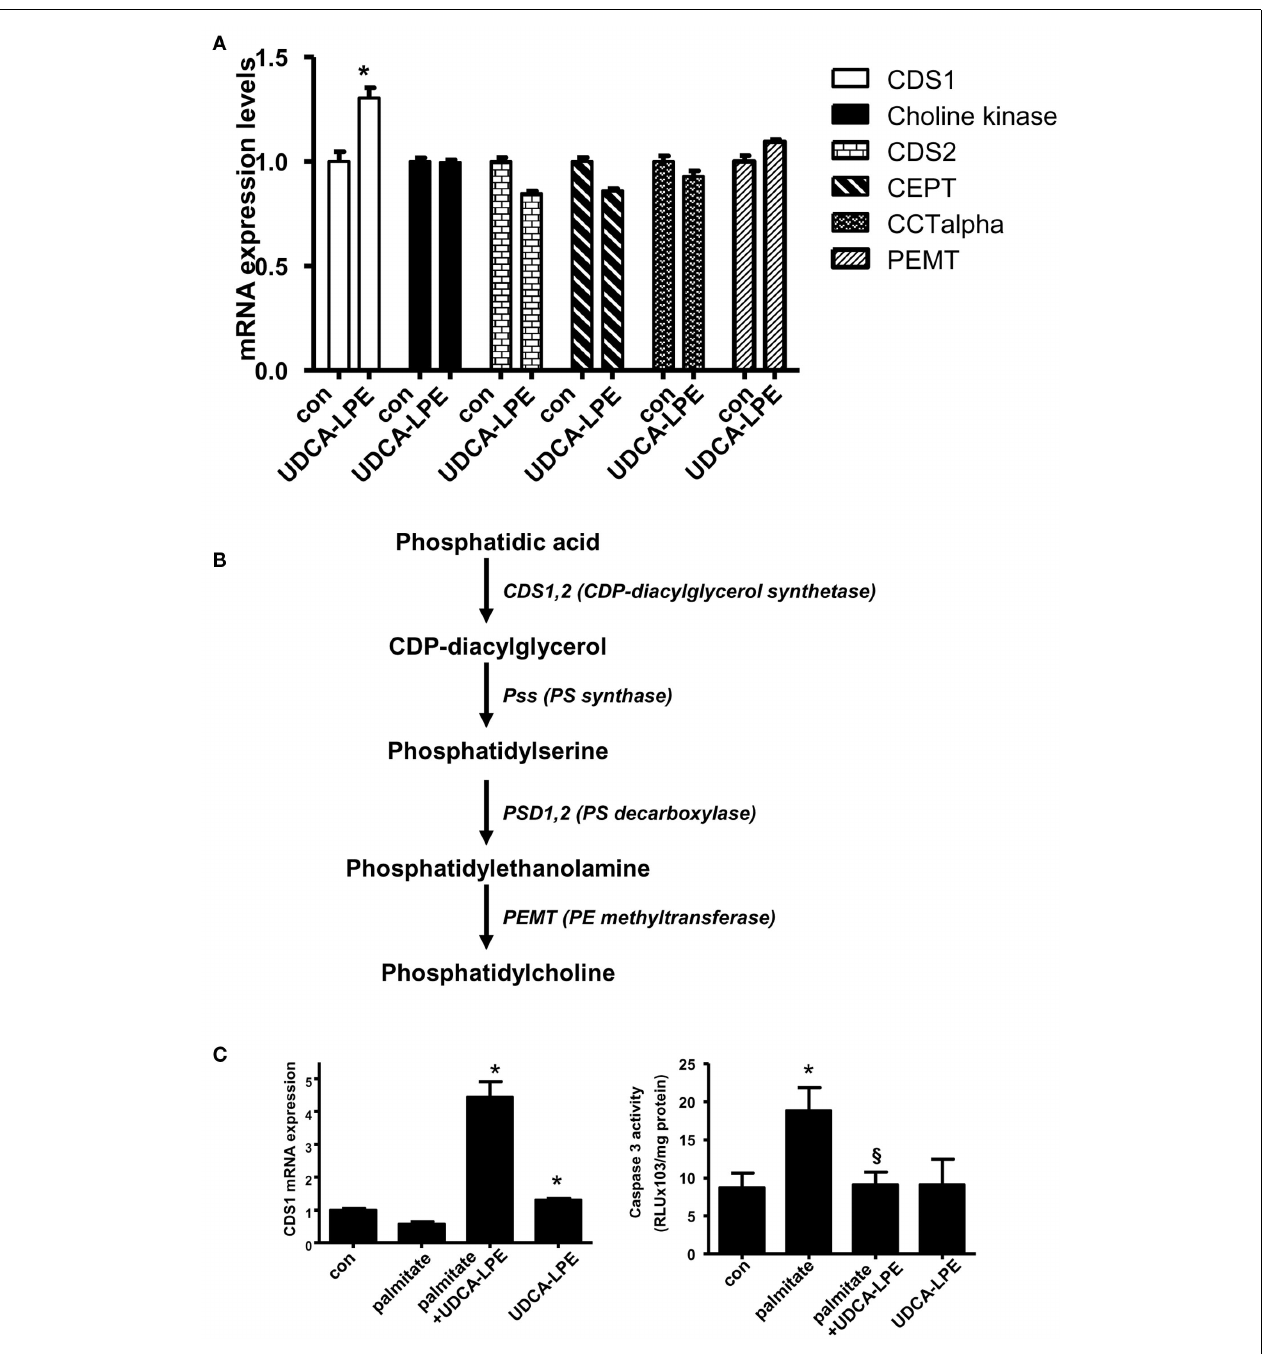
phosphatidic acid by CDS1. Intermediate lipids were metabolized by PS synthase, PS decarboxylase, and finally PE methyltransferase to result in increased PC abundance. (C) Co-treatment of UDCA-LPE with palmitate markedly upregulated expression of CDS1 after 20h treatment (left panel). Quantitative RT-PCR was carried out as in (A) . Concomitantly, palmitate-induced apoptosis as determined by caspase 3 activity was significantly inhibited by UDCA-LPE (right panel). Data are mean ± SD, N = 6; * p < 0.05 versus control; § p < 0.05 versus palmitate. “Con” represents control hepatocytes treated with 0.5% BSA used as a